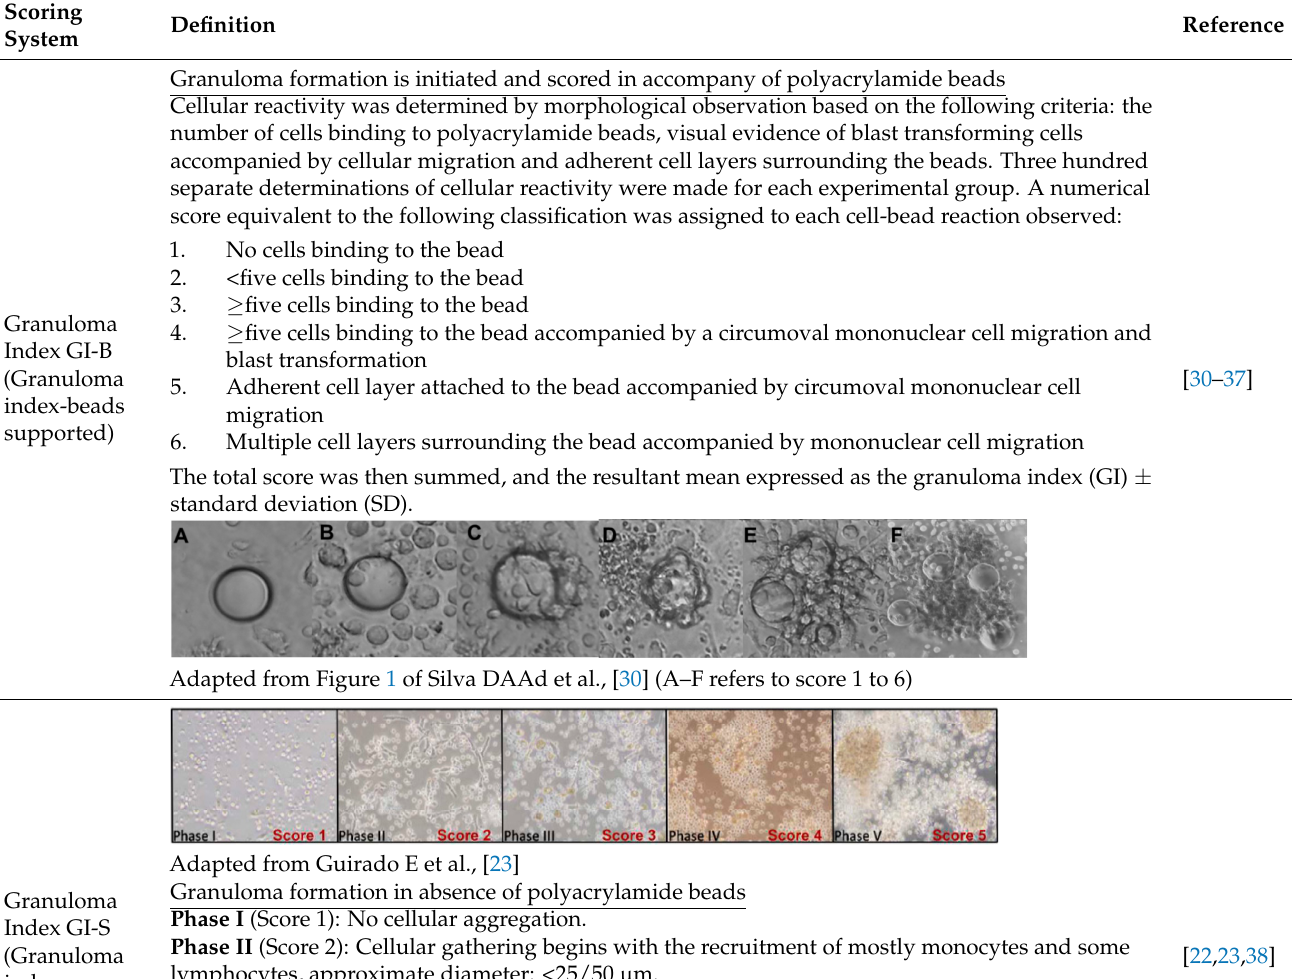
Table 1. Characterization of granuloma-like structures with established